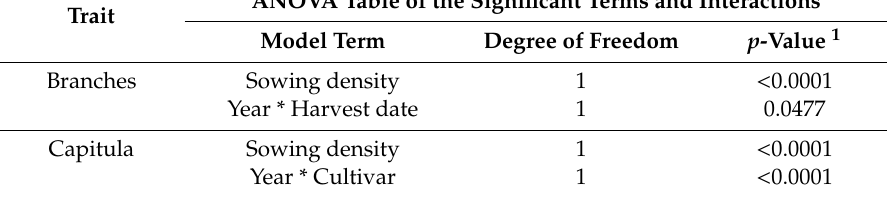
Table 4. ANOVA table of the significant terms and interactions in number of primary branches and capitula per